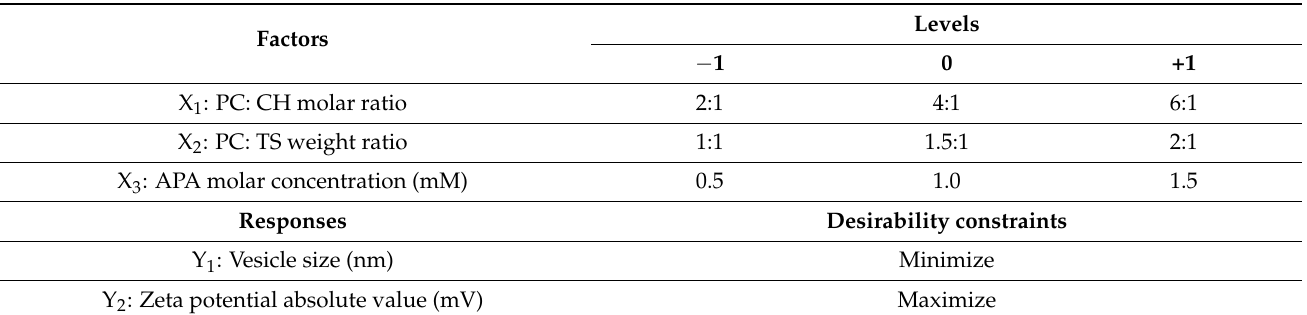
Table 3. Face-centred central composite design (FCCCD) coded and actual variables’ levels along with the desirability constraints of the responses applied for optimization of EGA-EML-APA. Factors